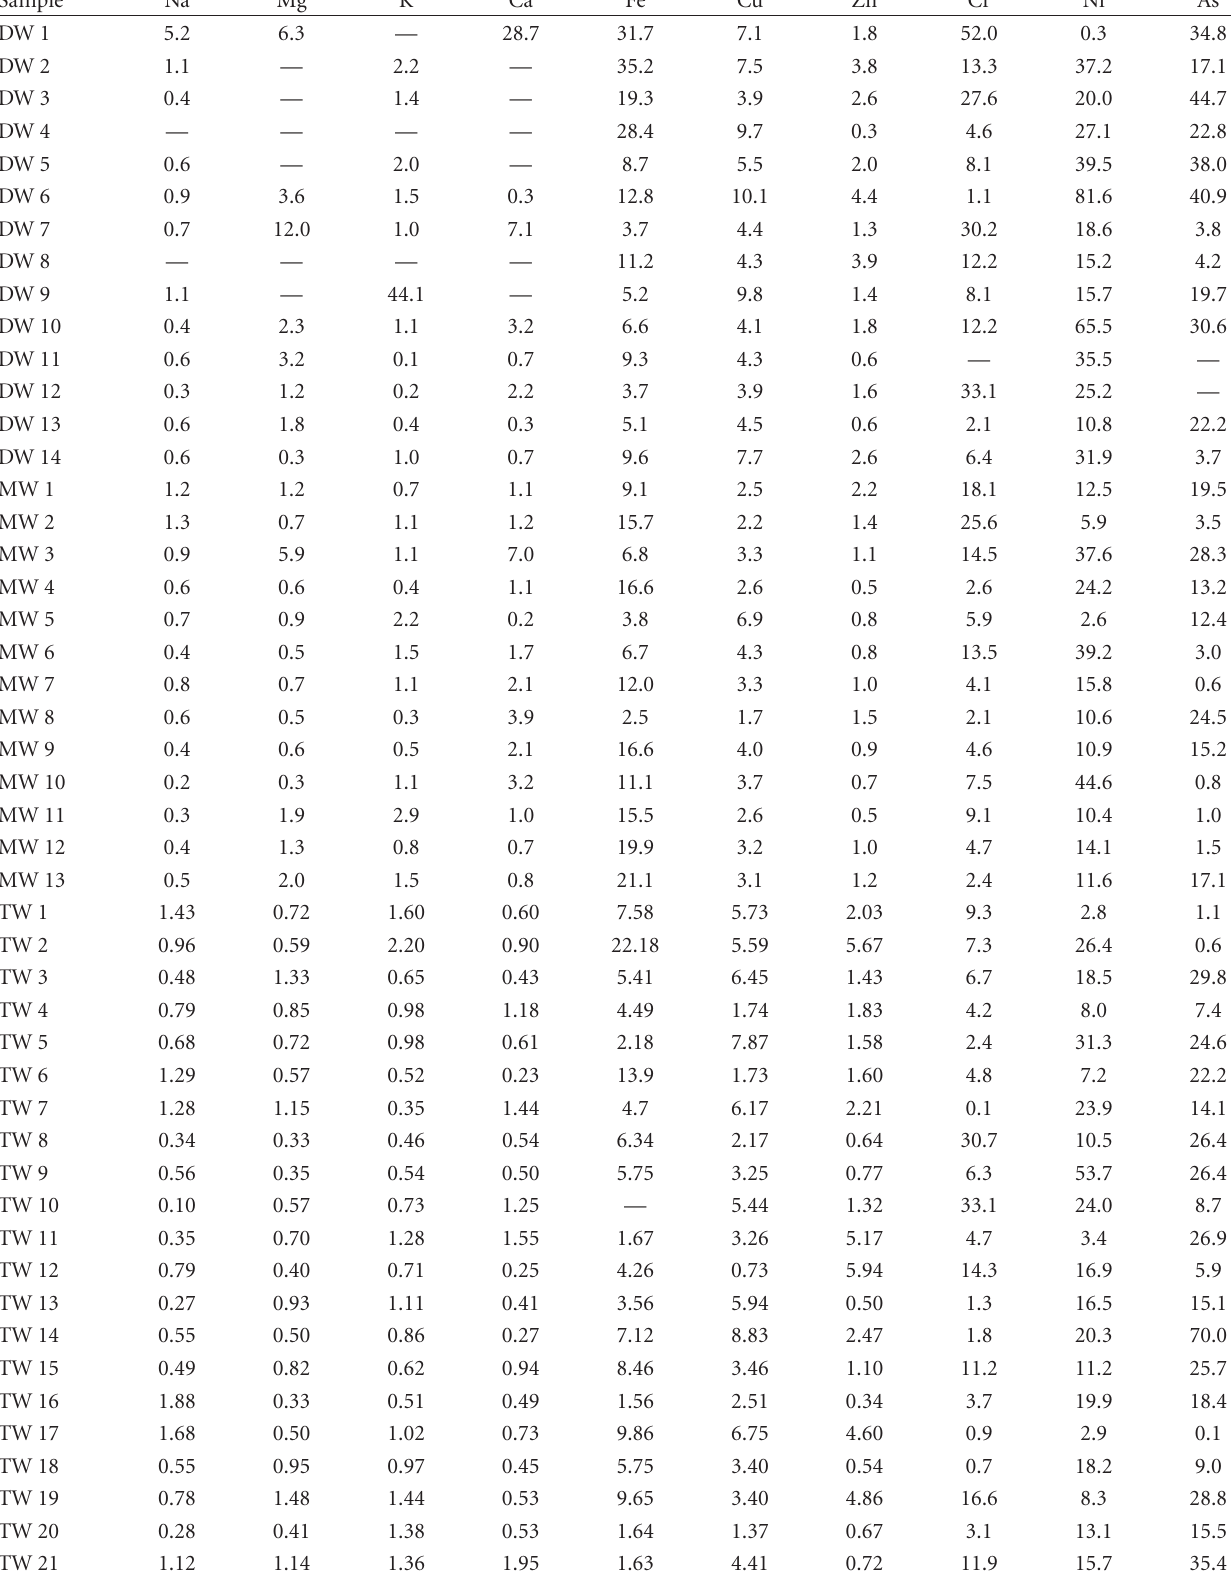
Table 5: Percentage of relative standard deviation (RSD) of minerals in drinking water (DW), mineral water (MW), and tap water (TW) samples.